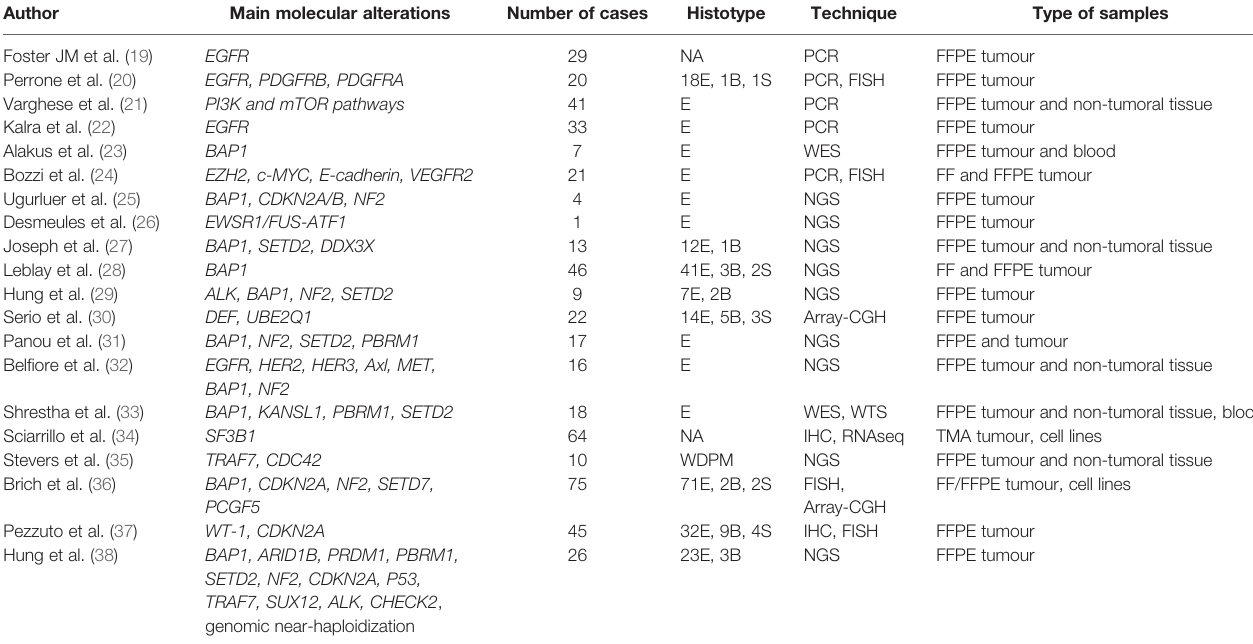
TABLE 1 | Previous molecular research studies.